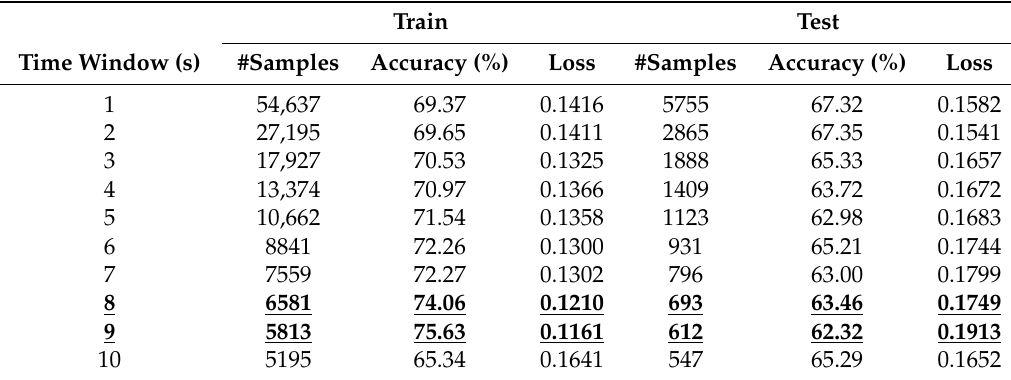
Table 6. Results obtained with EEG network classifying Arousal (best time windows are marked). Train Test Time Window (s)